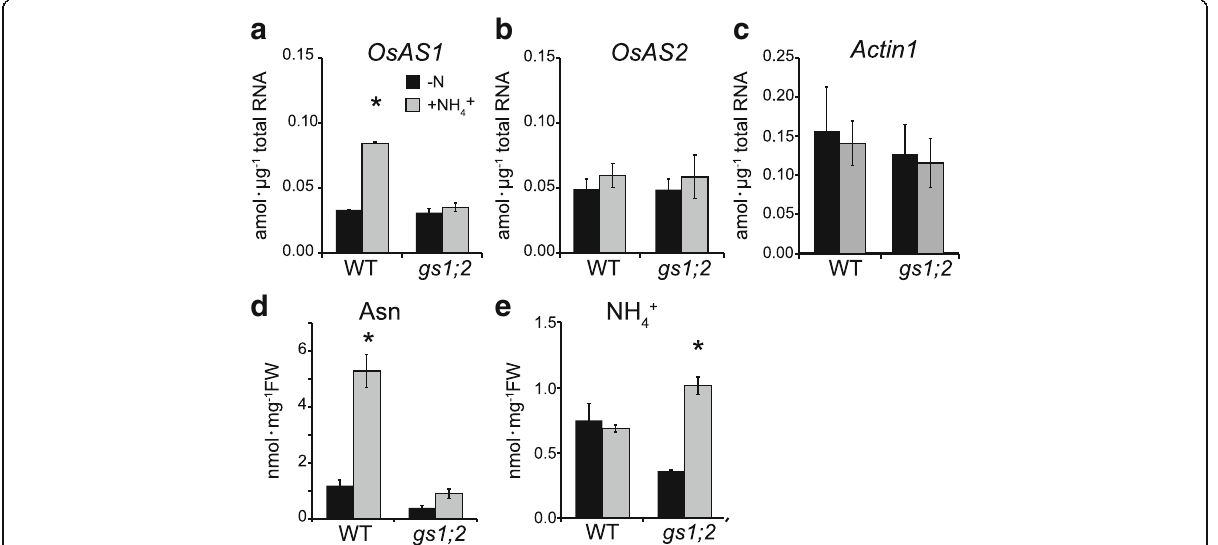
Fig. 4 Expression levels of OsASs and contents of asparagine and NH 4+ in the basal portions. a - c Transcript contents of the OsAS1 ( a ), OsAS2 ( b ) and a control Actin1 ( c ) in the basal portions of shoots of wild-type plants (WT: black column) and gs1;2 mutants ( gs1;2 : grey column) at the seventh-leaf stage for seedlings grown in water for 3 d followed by treatments with (+NH 4+ ) or without (-N) 1 mM NH 4 Cl for 8 h. ( d , e ) Contents of asparagine ( d ) and NH 4+ ( e ) in the basal portions of shoots of WT (black column) and gs1;2 (grey column) at the fourth-leaf stage for seedlings grown in water for 3 d followed by treatments with or without 1 mM NH 4 Cl for 24 h. Mean values with SE of four independent samples are shown. Asterisks denote statistically significant differences between samples treated with and without 1 mM NH 4 Cl (*, P < 0.05 by Student ’ s t -test)